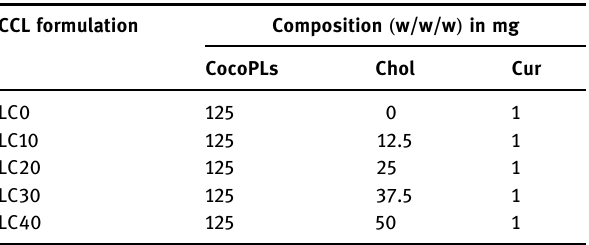
Table 1: Formulation of curcumin - loaded coconut liposomes ( CCL ) dispersions